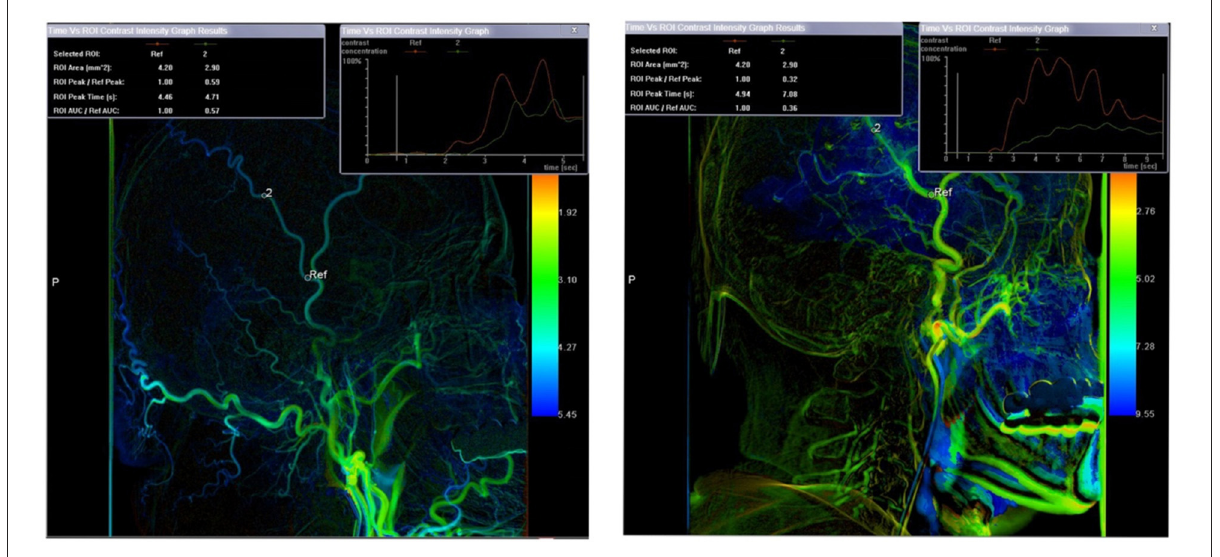
FIGURE1 Color-coding digital subtraction angiography (CC-DSA) for Moyamoya disease (MMD) and the measurement principle of hemodynamic parameter. Preoperative view (left) , postoperative view (right) .